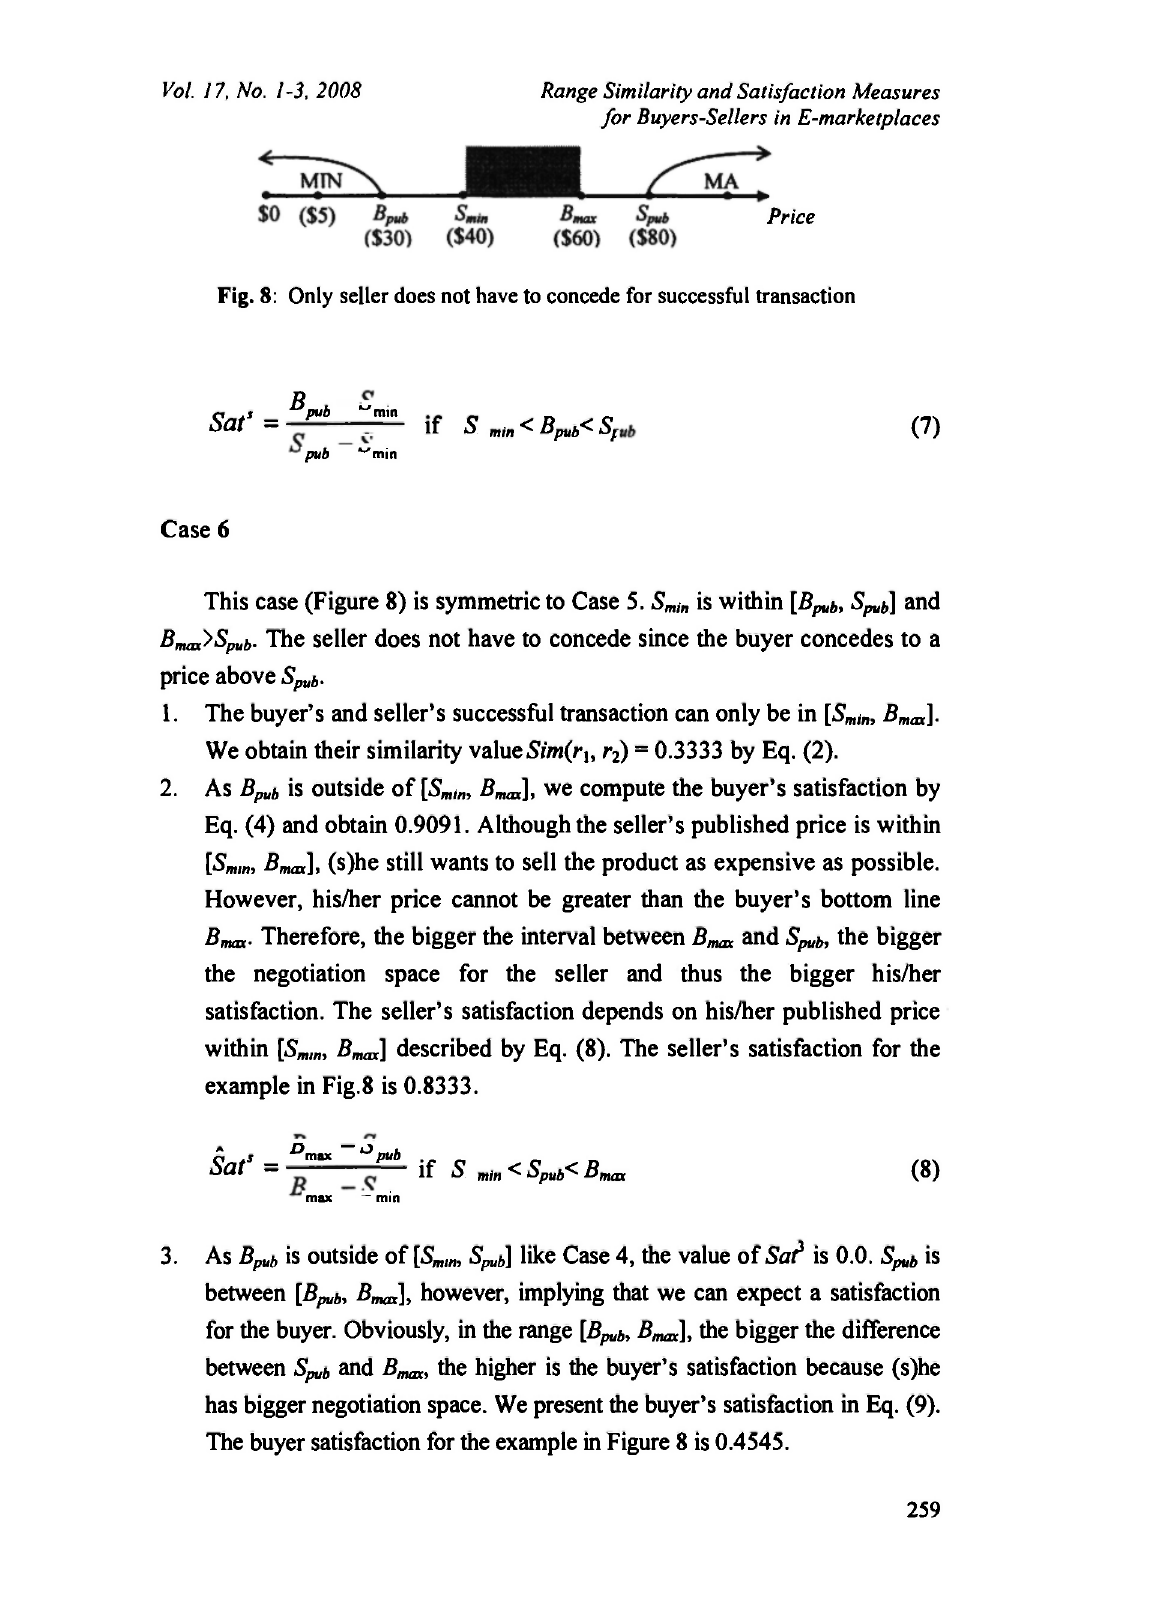
Fig. 8: Only seller does not have to concede for successful transaction